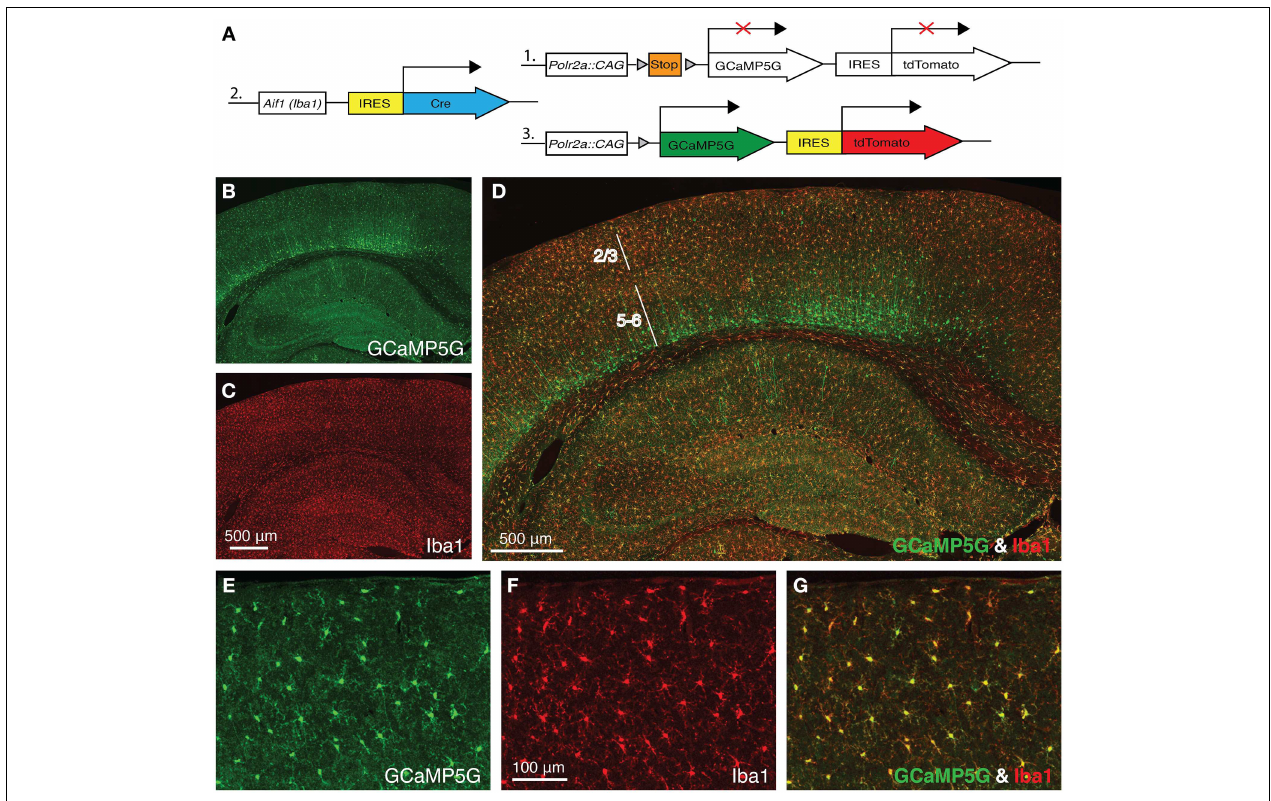
FIGURE 1 | Aif1 -IRES-Cre driver labels Iba1-positive microglia. (A) A schematic diagram of the PC::G5-tdT allele (1) crossed with Aif1 -IRES-Cre (2). Expression of IRES-Cre at the Aif1 locus results in the expression of GCaMP5G and tdTomato following Cre-mediated excision of the STOP cassette (3). (B–D) A coronal section of Aif1 -IRES-Cre; PC::G5-tdT brain stained with anti-GFP (GCaMP5G) and anti-Iba1 antibodies. (B) The section was imaged specifically in the green channel (GCaMP5G expression), (C) red channel (Iba1 expression)